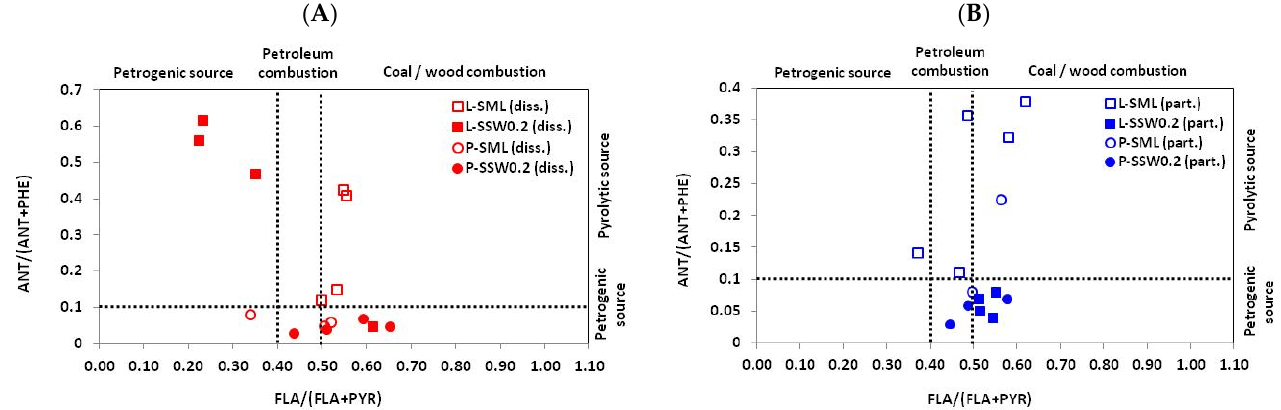
Figure 4. ANT/(PHE + ANT) and FLA/(FLA + PYR) ratios of PAHs in the dissolved ( A ) and particulate ( B ) phases of Loutropyrgos (L) and Pahi of Megara ( p ) sampling sites.